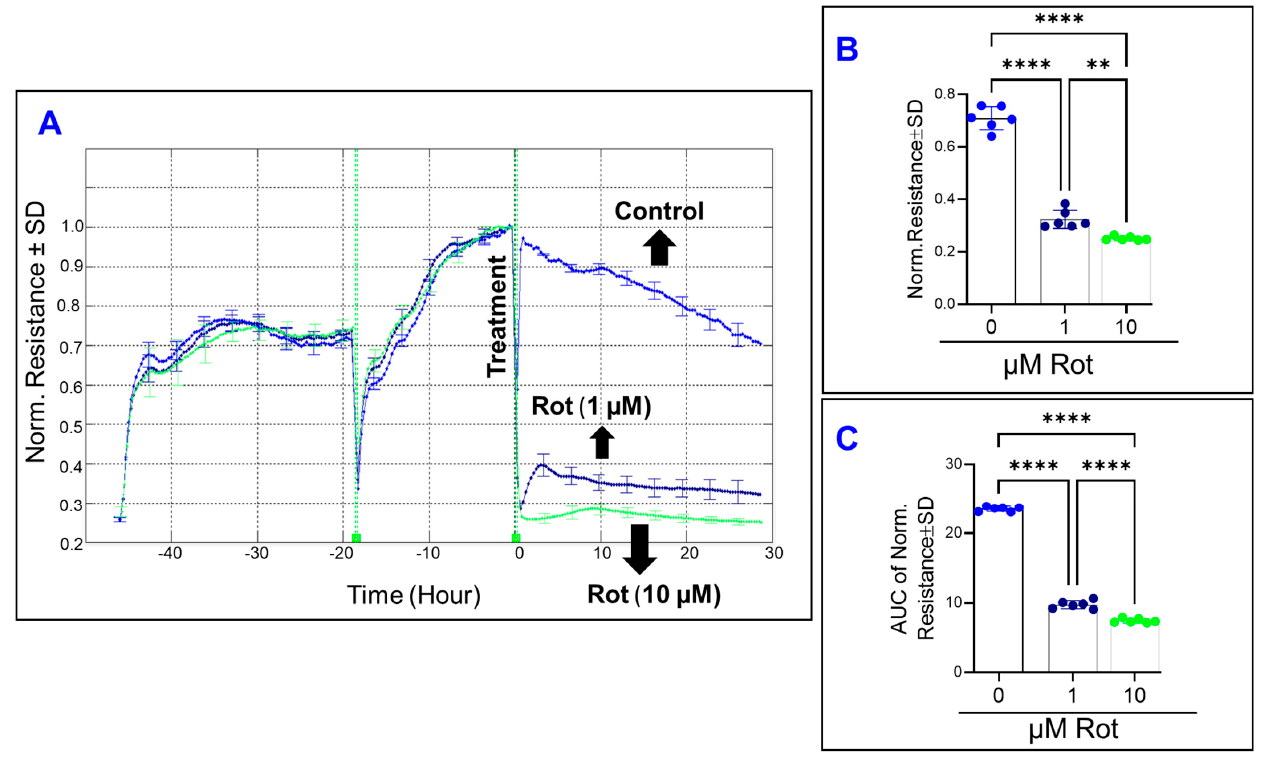
Figure 9. The effect of rotenone on human retinal endothelial cells’ total resistance. ( A ) The total resistance of HRECs after treatment with vehicle (DMSO) or rotenone (Rot; 1 and 10 µM) was measured at an AC frequency of 4000 Hz and represented by plotting normalized resistance vs. time. The resistance value at time 0 (R 0 ) was used to normalize all other resistance measurements. ( B ) The bar graph represents each group’s normalized resistance at the time (t = 30 h). ( C ) AUC of the normalized resistance measured at the time interval t = 0–30 h. Statistical analysis was performed using the ANOVA test followed by the Tukey post hoc test. Abbreviations: Norm, normalized; AUC, area under the curve; **, p ≤ 0.01; **** p , ≤ 0.0001.